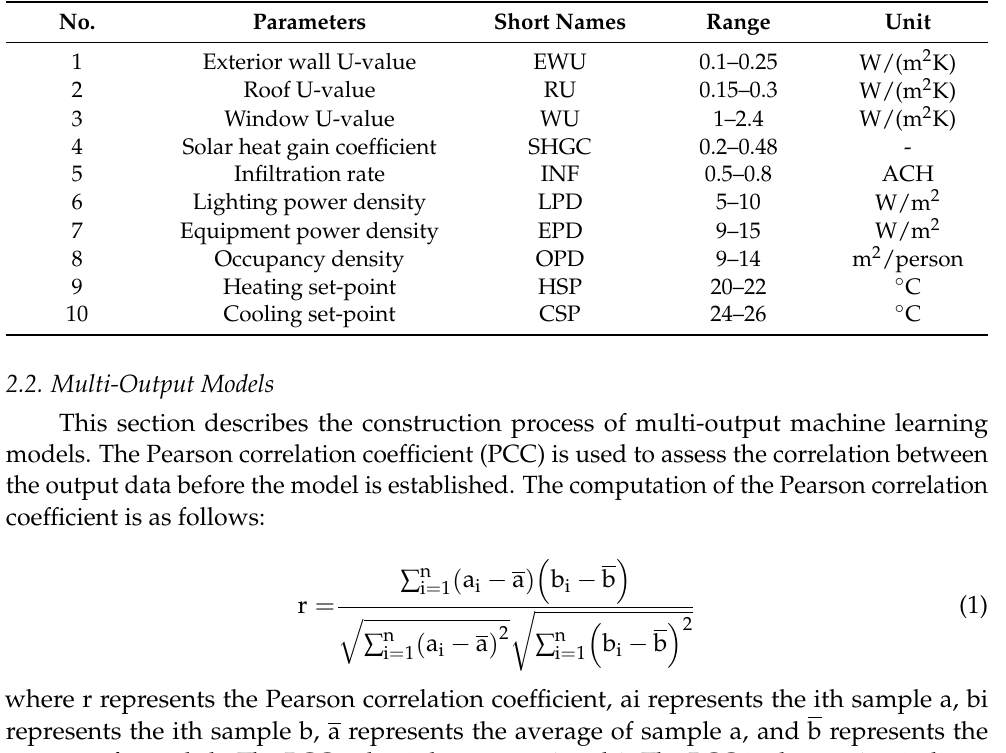
Table 1. Variation of building input